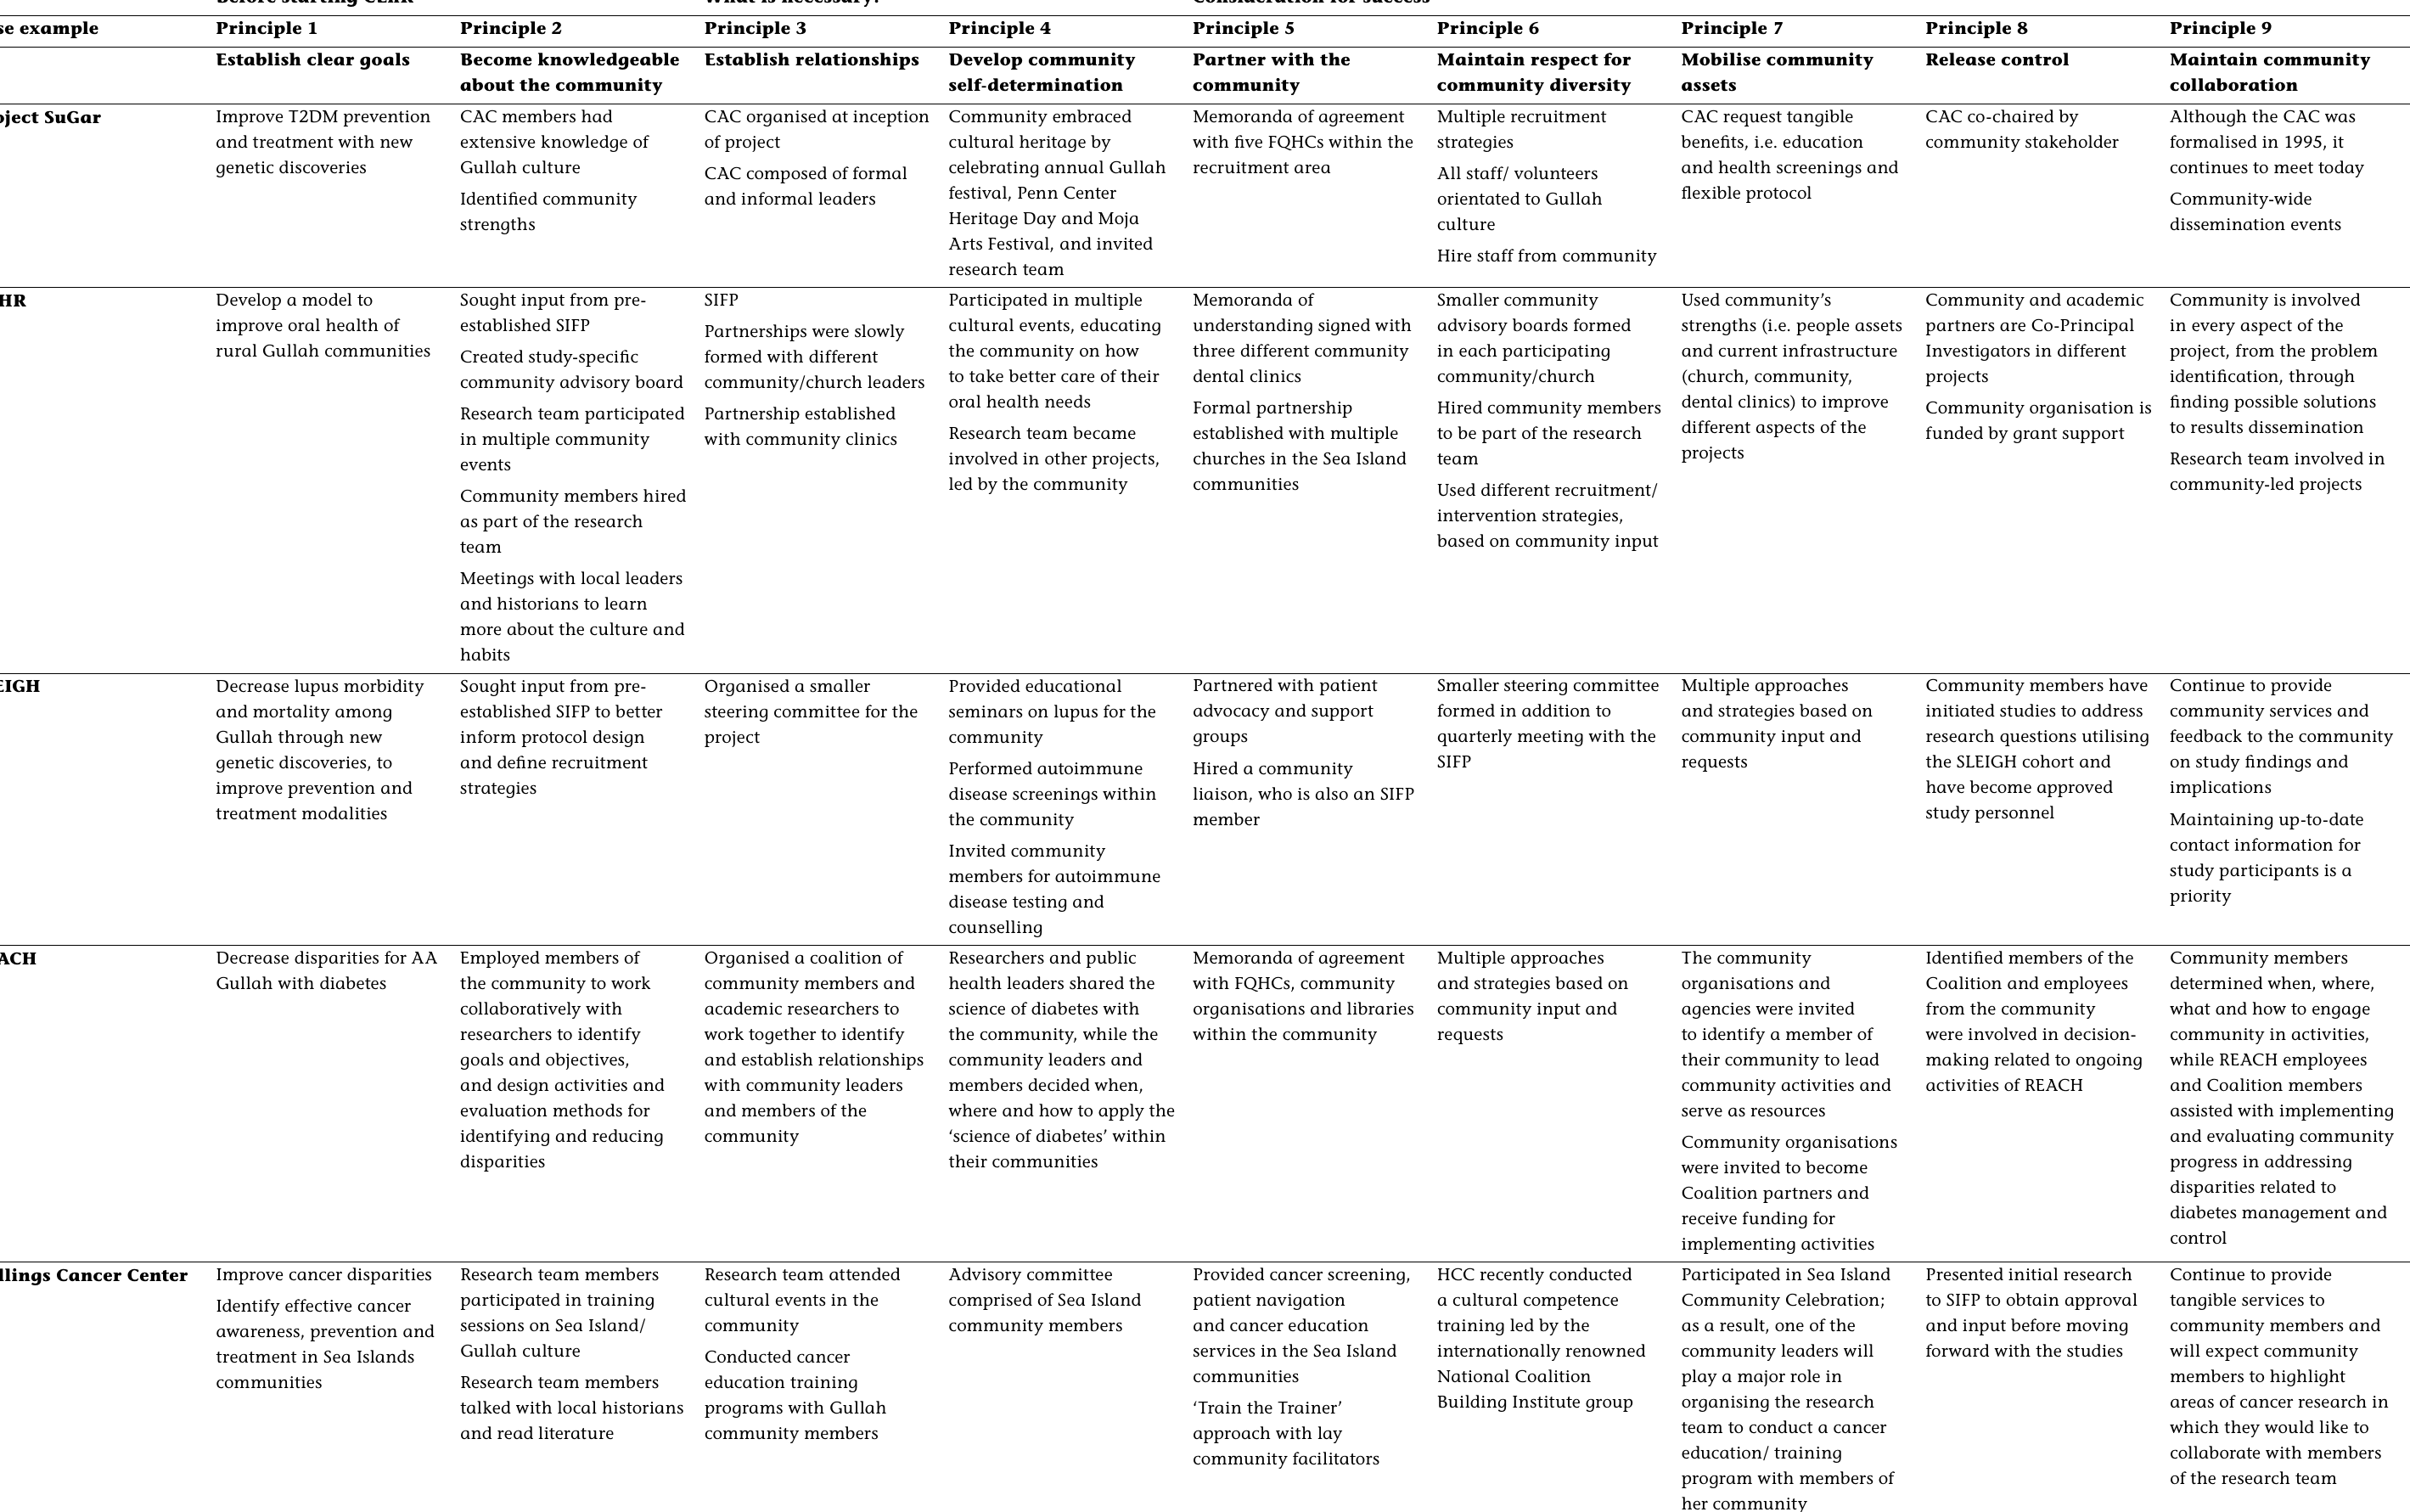
Table 2: Case studies and principles for community